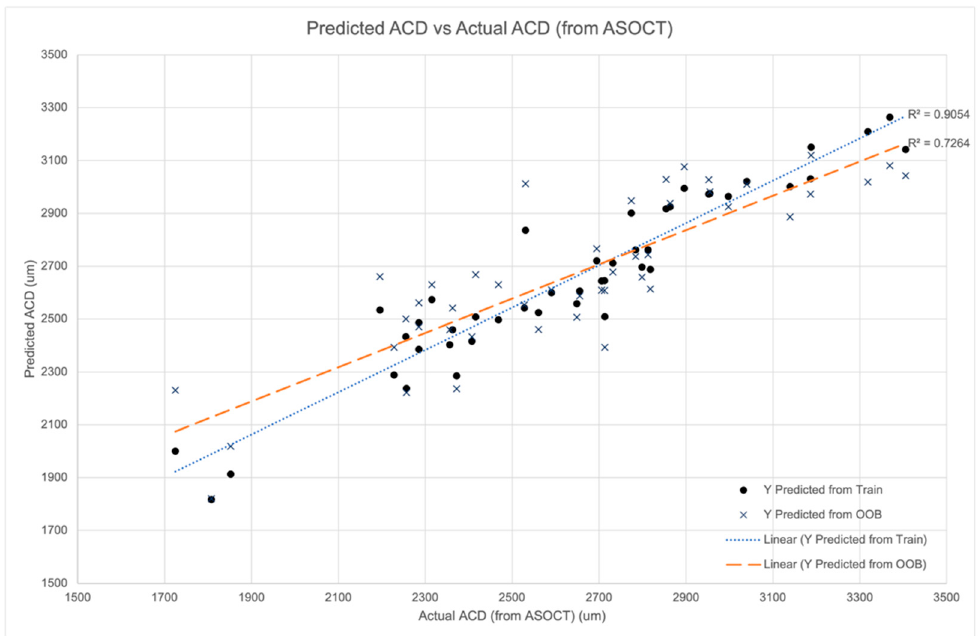
Figure 3. Training data validation. Central anterior chamber depth (ACD) values predicted from the training data vs. actual ACD from ASOCT.